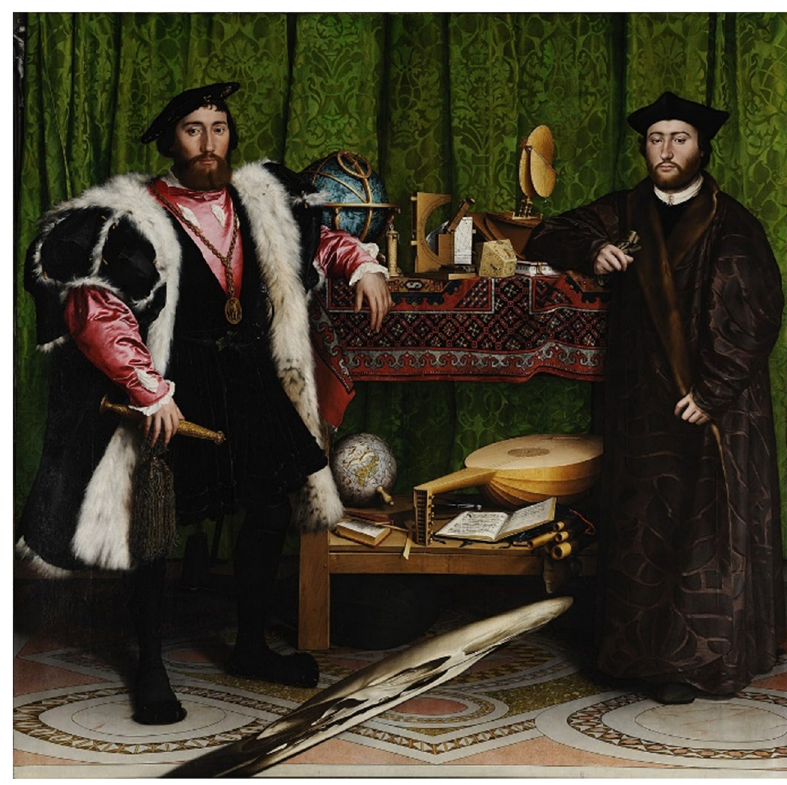
Figure 3: Hans Holbein, The Ambassadors ( 1533 )